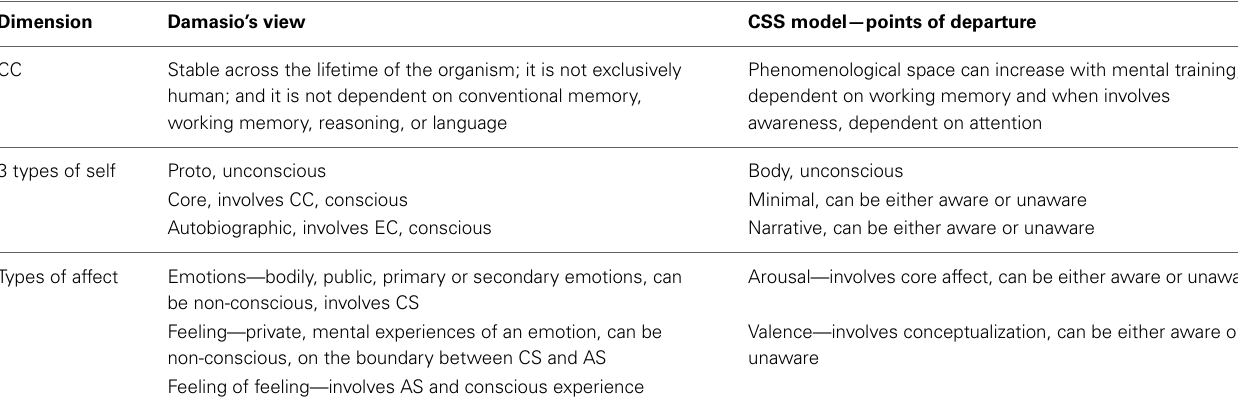
Table 1 | A comparison between Damasio’s (1999) theory of consciousness and the CSS model, describing points of departure. Dimension CSS model—points of